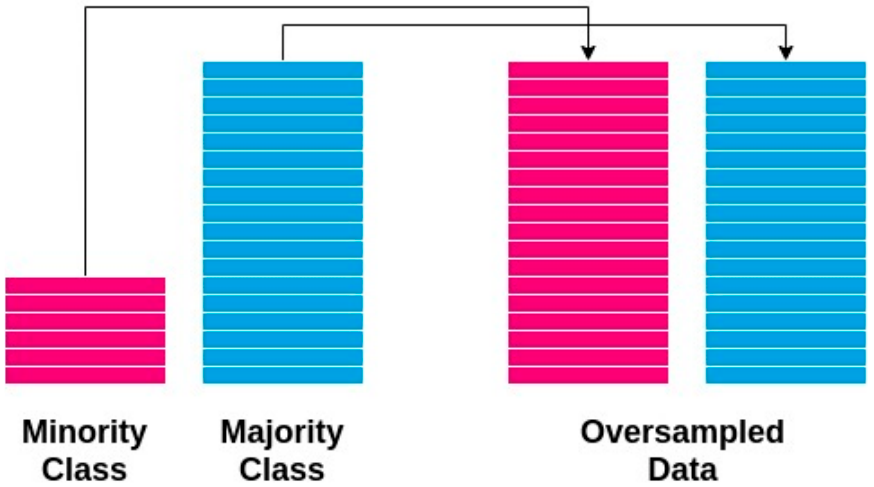
Figure 3. Illustration of Random Over-Sampling technique. This algorithm randomly selects instances from the minority class, with replacement, and adds them to the training dataset.